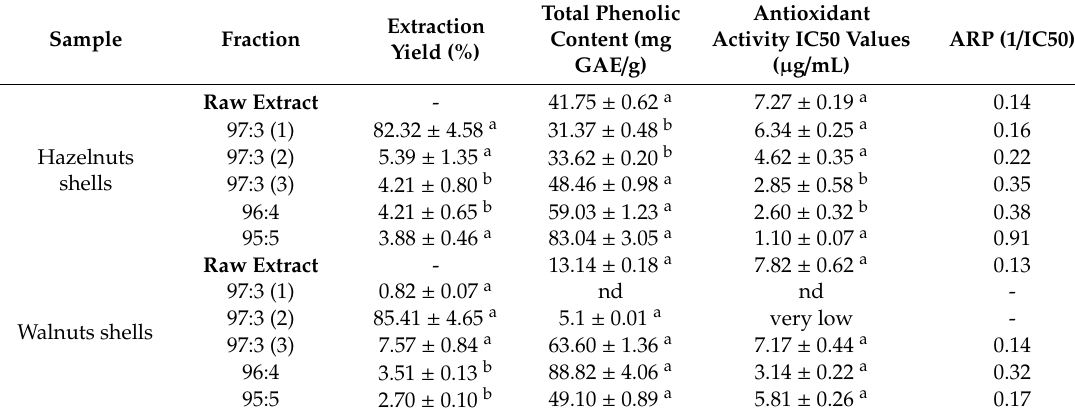
Table 5. Yield of (% of dry mass) total phenolic content and antioxidant activity of the polar extracts and their